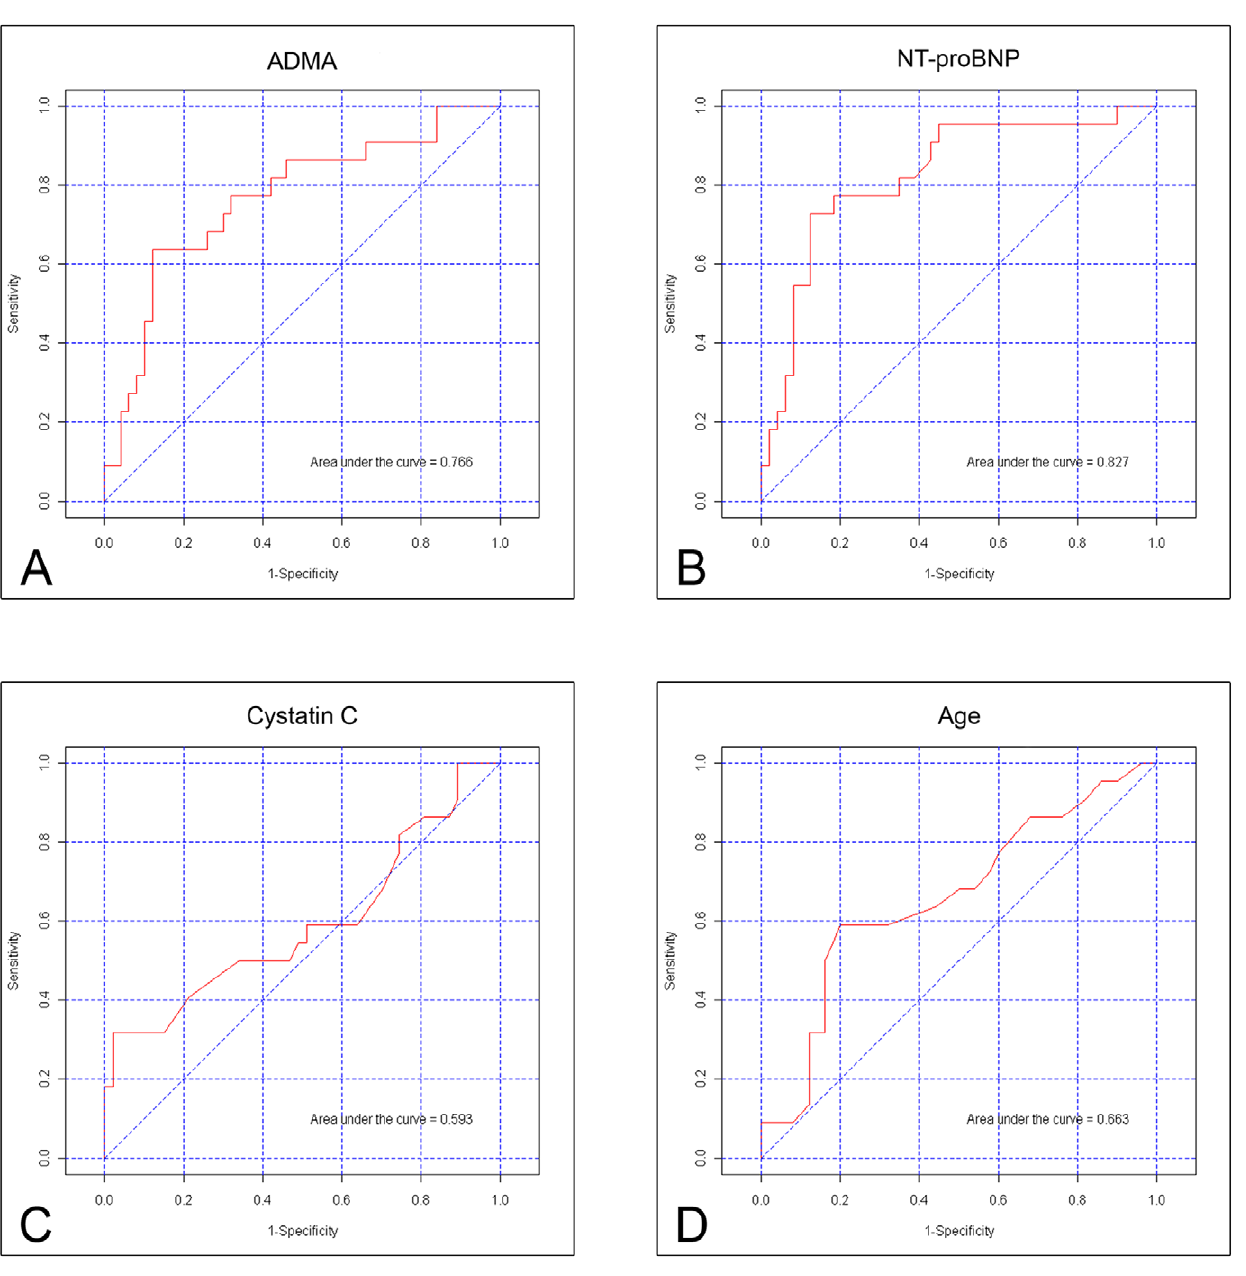
Figure 2. Receiver-operating characteristic (ROC) curves for identifying patients with severely limited cardiopulmonary exercise